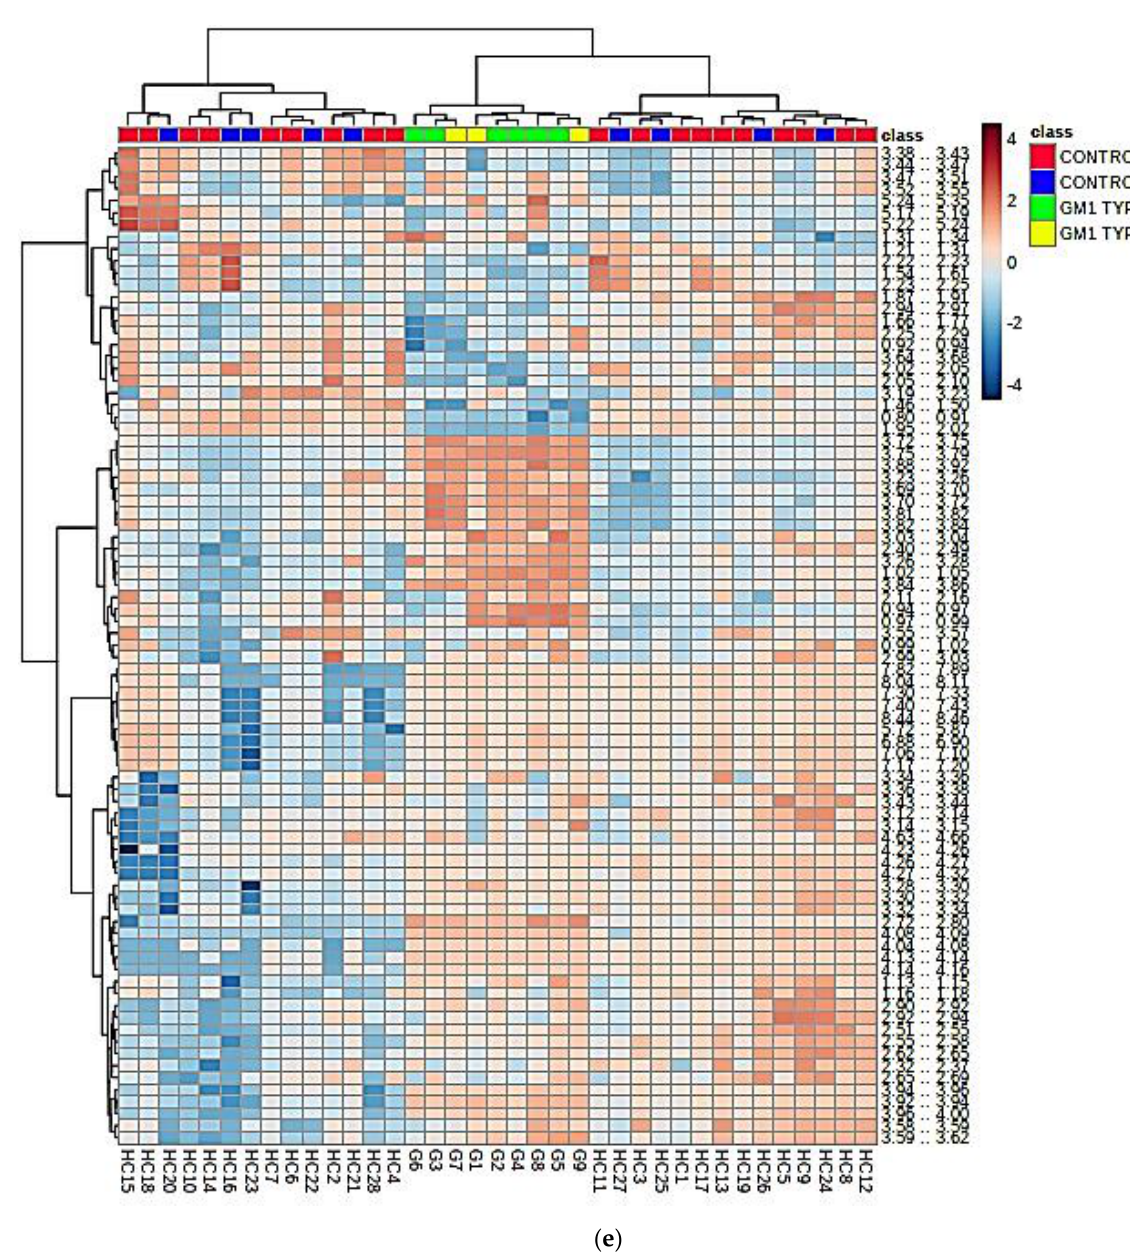
Figure 2. ( a ) AHC biclustering heatmap diagram displaying the most univariately-significant differences between the 1 H NMR profile predictor metabolite variables of the GM1T2 (green) and HC (red) groups investigated (Model 2 dataset); those for all 25 variables are shown (near right-hand side y -axis). 1 H NMR datasets were CS-normalized, glog-transformed, and Pareto-scaled prior to analysis. Transformed metabolite 1 H NMR intensities are shown in the far right-hand side y -axis: deep blue and red colorations represent extremes of low and high concentrations, respectively. The left-hand side of the plot shows results arising from an AHC analysis of the top 25 metabolite variables monitored, which reveals 2 major metabolite clusterings, with 2 sub-clusterings within each of these. ( b ) AHC dendogram of a ‘training’ set consisting of n = 19 HC and n = 6 GM1T2 disease participant sample donors, and revealing clearly distinctive MV clusterings between the blood plasma 1 H NMR profiles of these groups for the Model 1 1 H NMR ISB dataset. ( c ) As ( b ), but with inclusion of the hold-out validation sampling set of n = 9 HC and n = 3 GM1T2 samples. ( d ) AHC biclustering heatmap diagram performed on the ‘training set’ of 19 HC and 6 GM1T2 for the Model 1 dataset. ( e ) As ( d ), but with incorporation of the hold-out validation sampling set. AHC models applied involved a consideration of maximum dissimilarities from Euclidean distances. Abbreviations: CONTROL_V and GM1T2_V represent samples of the hold-out validation set (blue and yellow color-coded labels, respectively).